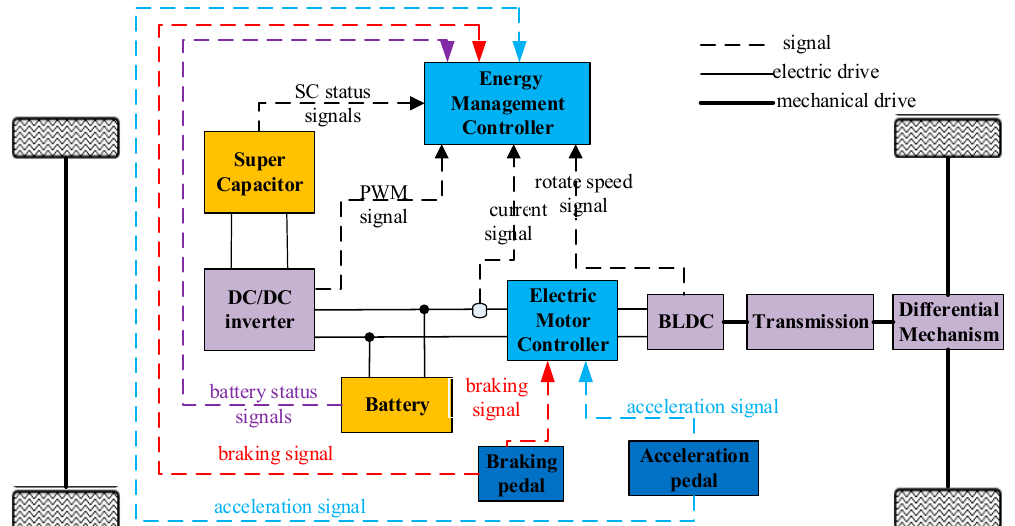
Figure 1. Architecture of the hybrid power system.